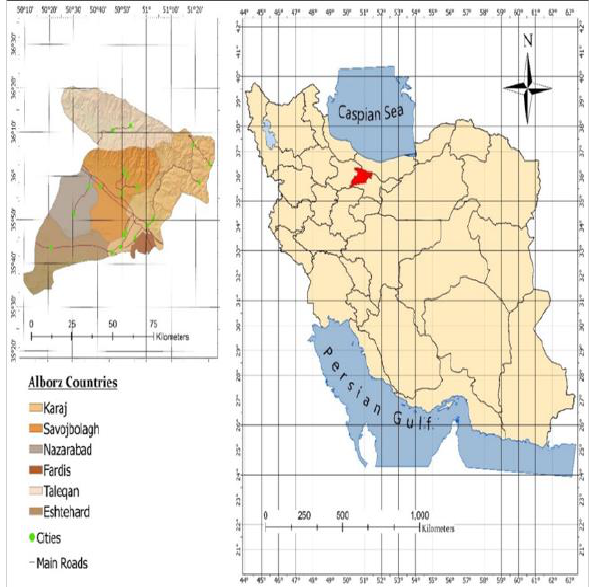
Figure 1 . Location of Alborz